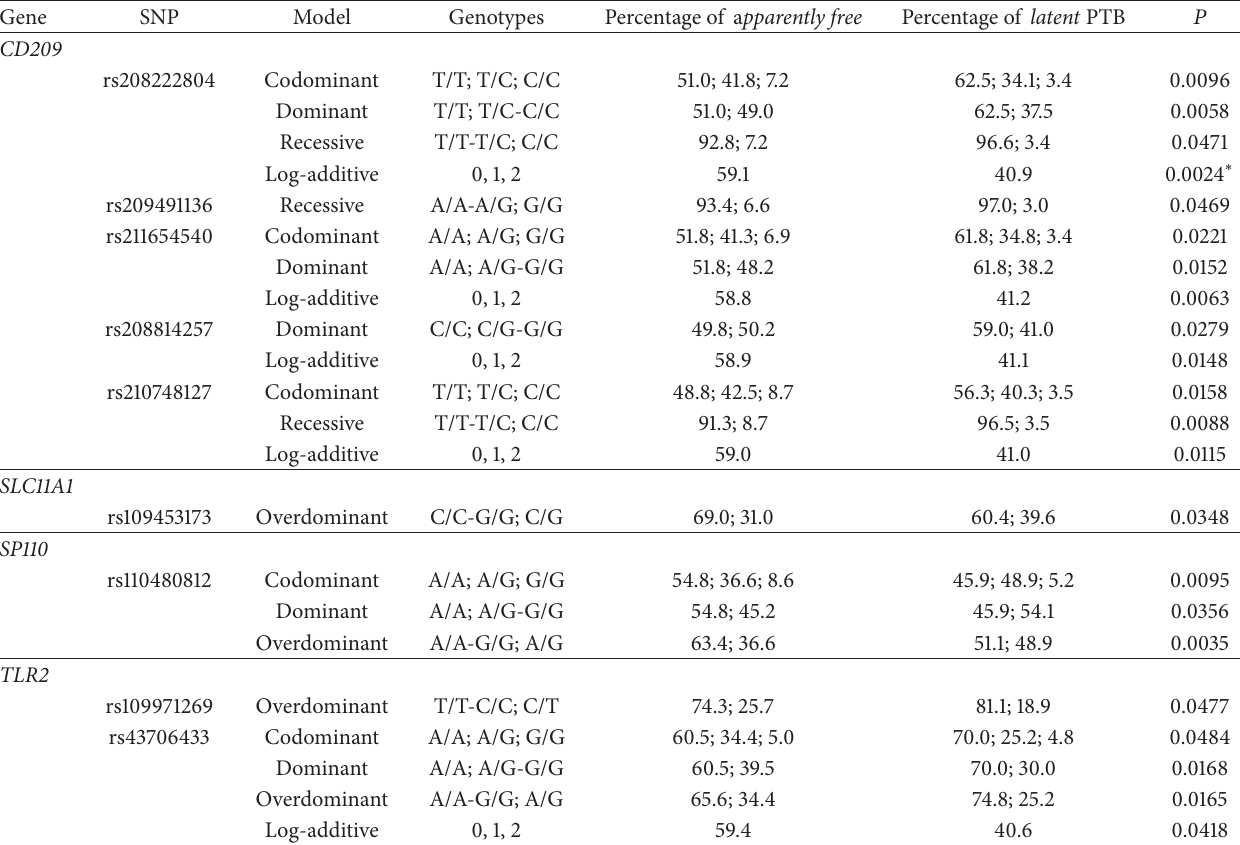
Table 2: Association results from apparently free versus latent PTB logistic regression analysis.